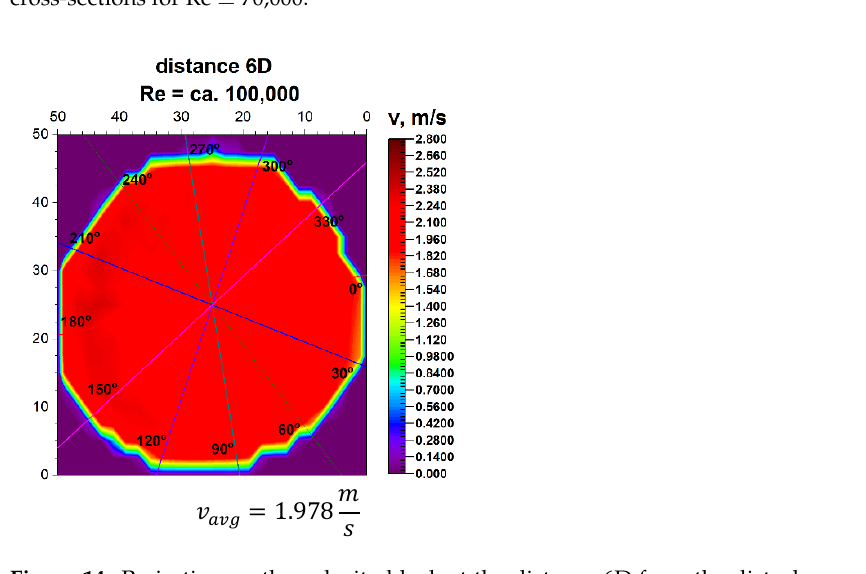
𝑚 𝑣 = 1.978 𝑎𝑣𝑔 𝑠